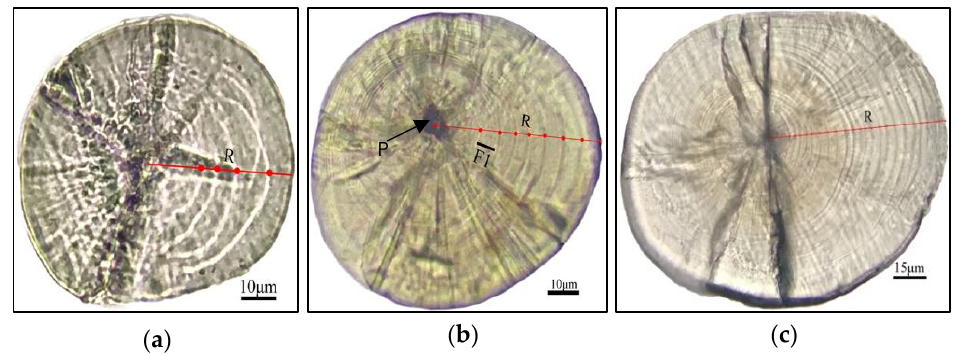
Figure 6. Lapilli otoliths of Sinogastromyzon wui. ( a ) The lapillus otolith of larva at 5 dph; showing the radius (R) along which increments were read and measured. ( b ) The lapillus otolith of larva at 9 dph, showing the primordium (P) and the first increment (F1). ( c ) The lapillus otolith of larva at 23 dph, showing the radius (R) along which increments were read.